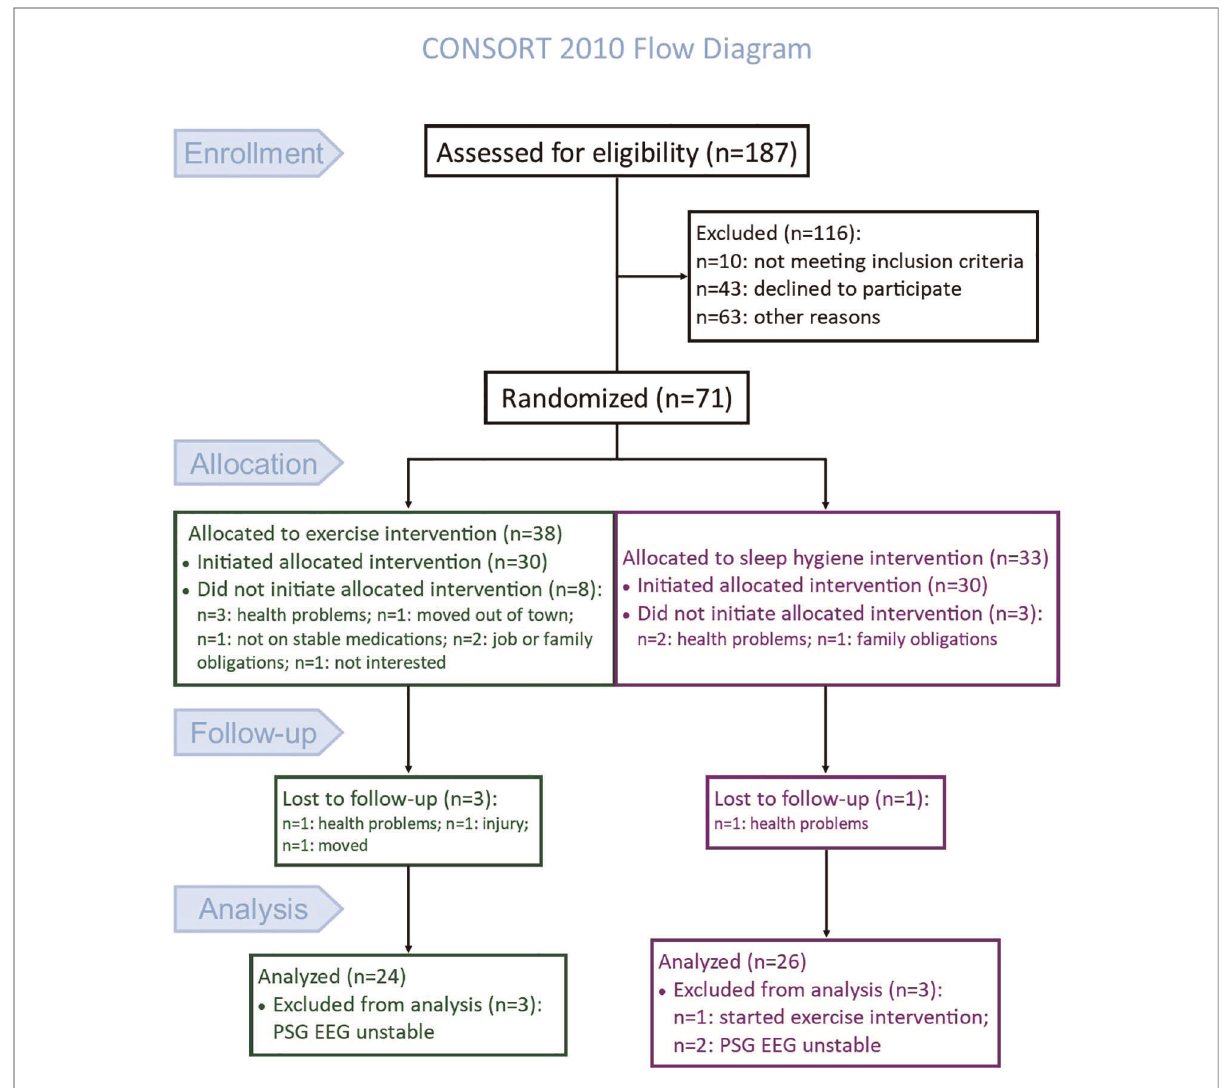
FIGURE 1 Consort fl ow